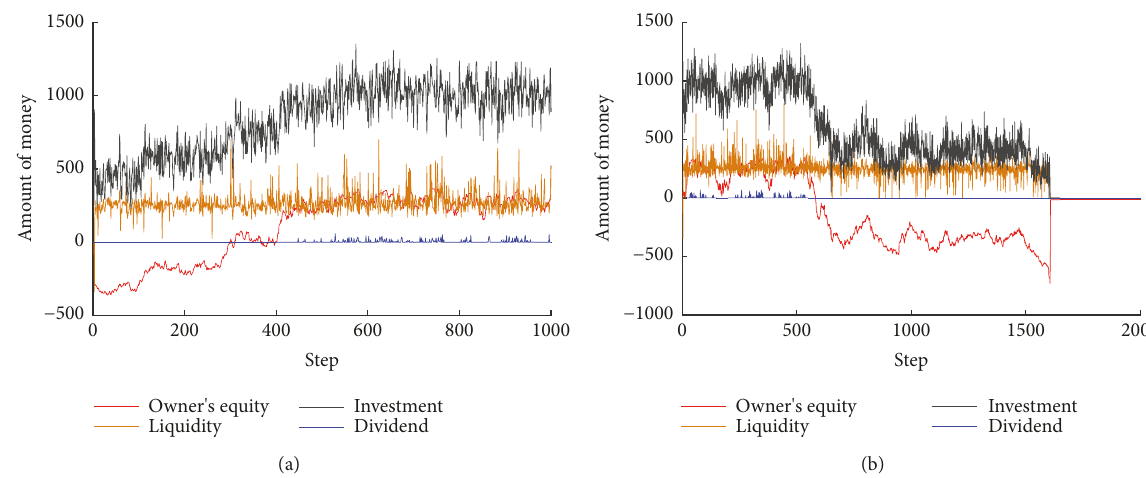
Figure 4: (a) The evolutionary process of a bank with negative initial value of ownership, but it eventually can run a stable operation. (b) The evolutionary process of a bank with positive initial value of ownership, and it finally goes bankrupt. The parameters are set as 𝑑 = 0.0533 , 𝛿 = 0.009 , 𝜃 = 0.06 , 𝑝 = 0.05 , 𝐶 = 0.03 , 𝜎 = 0.15 , 𝜎 = 0.25 , 𝐴 = 1000 , 𝑤 = 500 , 𝜒 = 0.3 , 𝛽 = 0.25 , 𝐵𝑎𝑛𝑘𝑁𝑜 = 200 , 𝐴𝑠𝑠𝑒𝑡𝑁𝑜 = 150 , 𝑎 V 𝑒 𝐴 𝑤 𝑟 = 0.004 , and 𝑟 = 0.008 . 𝑎 𝑏